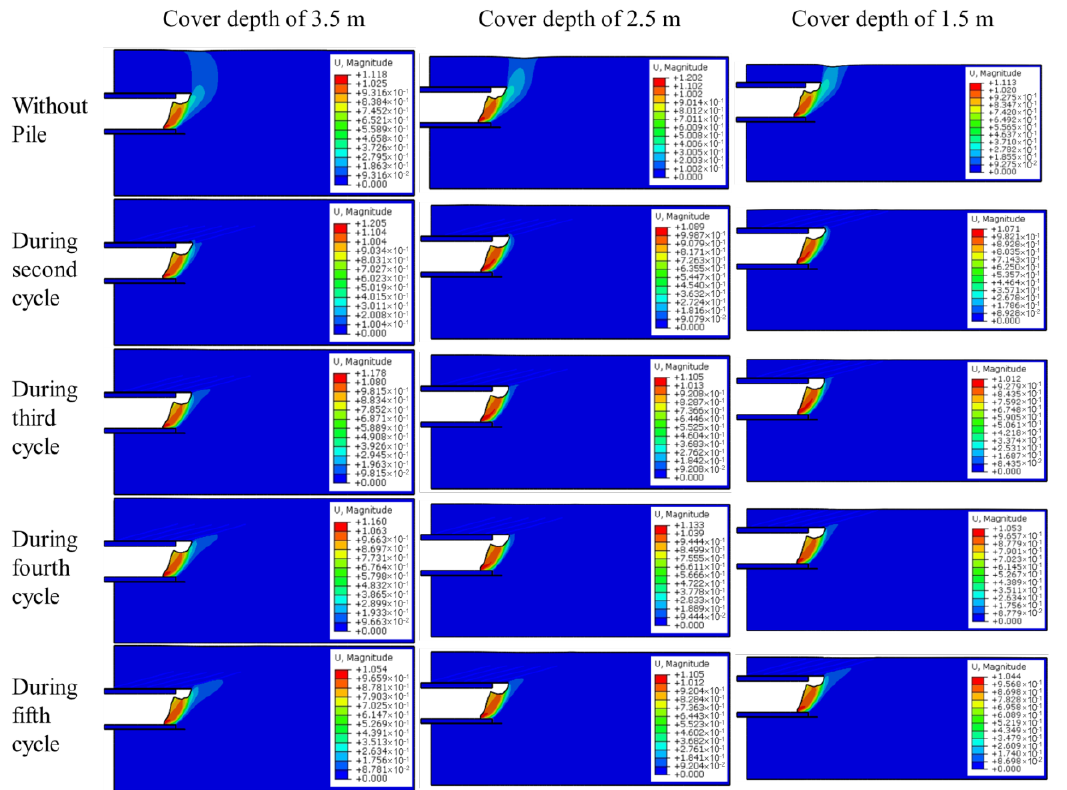
Figure 15. Ground displacement during Stage 1 of each construction cycle.